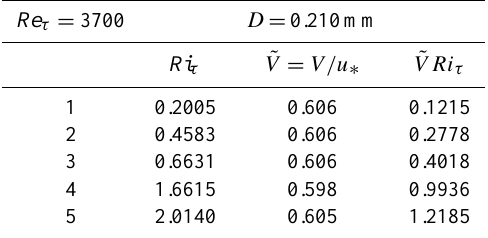
Table 5. List of all the experiments of Coleman (1986) used in our study.